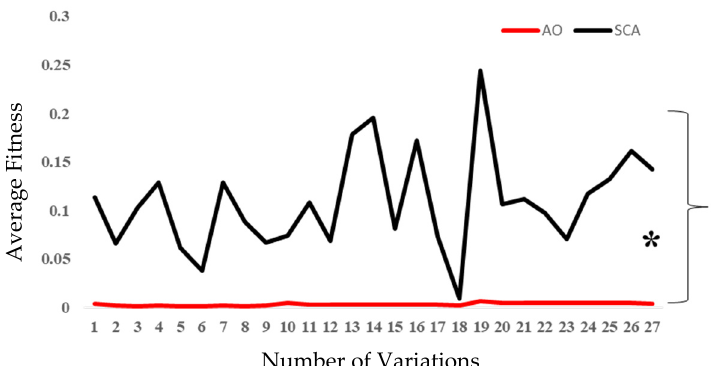
Figure 9. Mann-Whitney U test between AO and SCA where * p < 0.01.